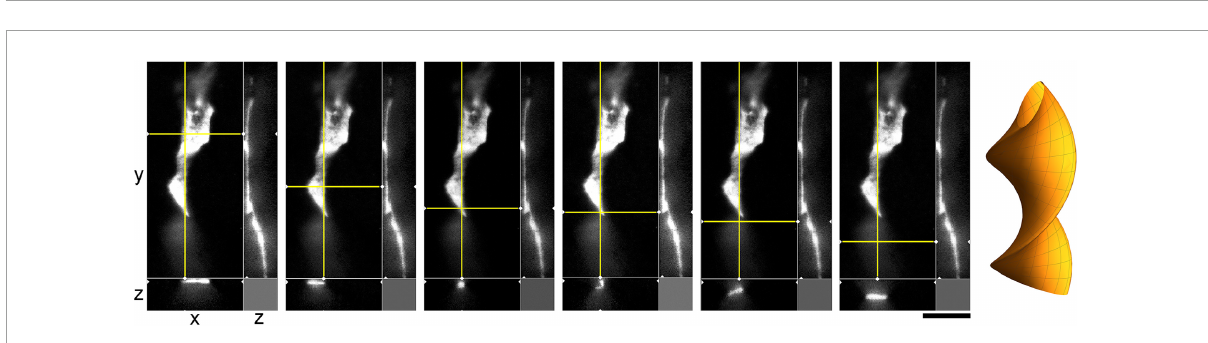
FIGURE10 A super-resolution microscopy (STED) images of a single serotonergic (5-HT +) axon in the sectioned cortical plate of a mouse embryo at E17. The axon is shown in all three dimensions, with a fixed yz-plane (at a constant x; the vertical yellow line) and a series of xz-planes (with six different y values; the horizontal yellow line). At the shown levels, the axon is flat (ribbon-like) and appears to rotate. This hypothetical cork-screw configuration is shown in the diagram on the right. Scale bar = 5 µ